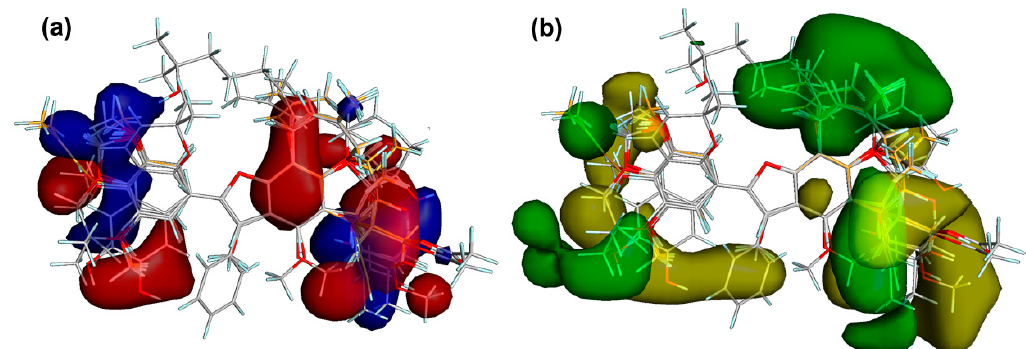
Figure 8. Contour maps from the field contributions from the comparative molecular field analysis (CoMFA). ( a ) Electrostatic contour maps. Blue and red contours depict zones where positive and negative charges, respectively, will favor the COX-2 inhibitory activity. ( b ) Steric contour maps. Yellow and green contours indicate regions where a bulky group is unfavorable and favorable, respectively, for COX-2 inhibition.